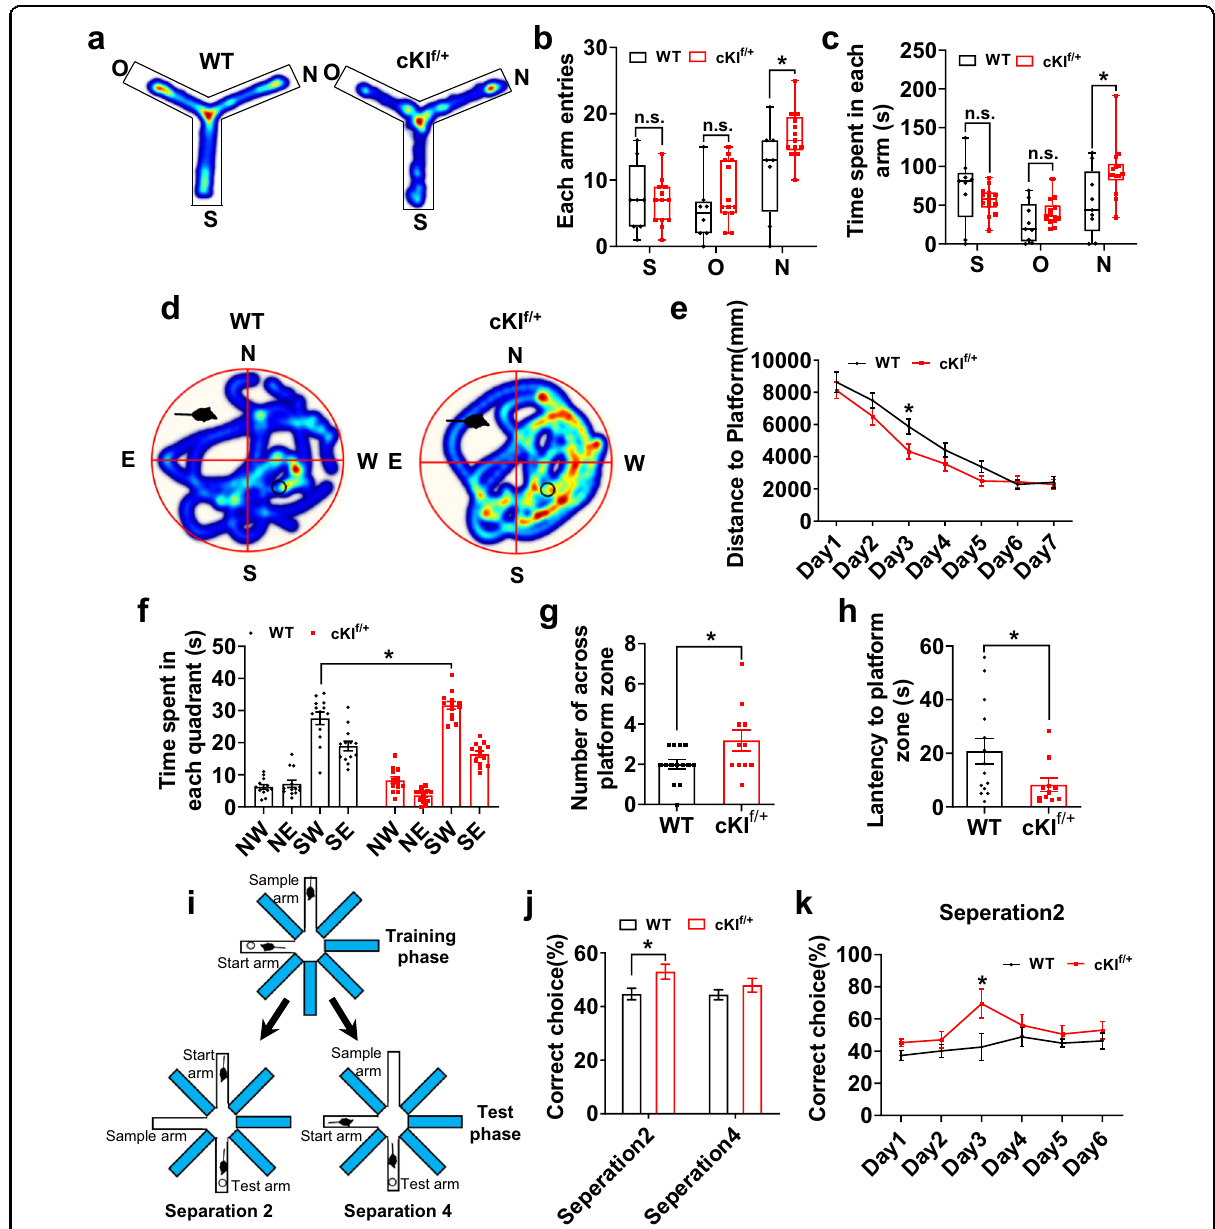
Fig. 6 Human SERPINA3 overexpression may improve learning and memory in mice. a Representative trace track of WT and cKI f/ + mice in Y-maze test. Start arm(S), Old arm(O), New arm(N). b Quanti fi cation for the entries of each arm between WT and cKI f/ + mice in the Y-maze test (WT n = 8; cKI f/ + n = 13). c Quanti fi cation for the time spent in each arm between WT and cKI f/ + mice in the Y-maze test (WT n = 9; cKI f/ + n = 14). d Representative tracing path of WT and cKI f/ + mice in Morris water maze test. e Quanti fi cation for the distance to the platform during the training process ( n = 13). f Quanti fi cation for time spent in each of the four quadrants of the water maze after the platform was removed following the initial 7 days of training ( n = 13). g Quanti fi cation for number of across platform zone (WT n = 14; cKI f/ + n = 11). h Quanti fi cation for latency to platform zone (WT n = 14; cKI f/ + n = 11). i Schematic drawing of the DNMP-RAM test. j Quanti fi cation for the percentage of correct choice in separation 2 test and separation 4 test (WT n = 16; cKI f/ + n = 12). k Quanti fi cation for the percentage of correct choice between WT and cKI f/ + mice in separation 2 test (WT n = 15; cKI f/ + n = 11). Two-tail unpaired t -test is used to analyze the data. n.s. no signi fi cant difference. P < 0.05 (*), P < 0.01 (**), P < 0.001